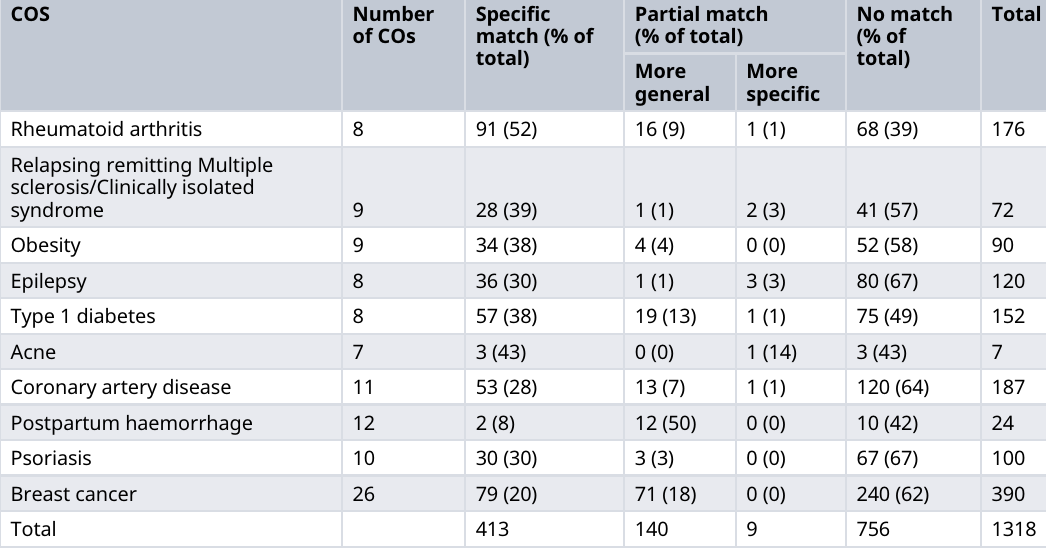
Table 3. The number of outcomes for each COS categorised as specific, partial or no match. COS